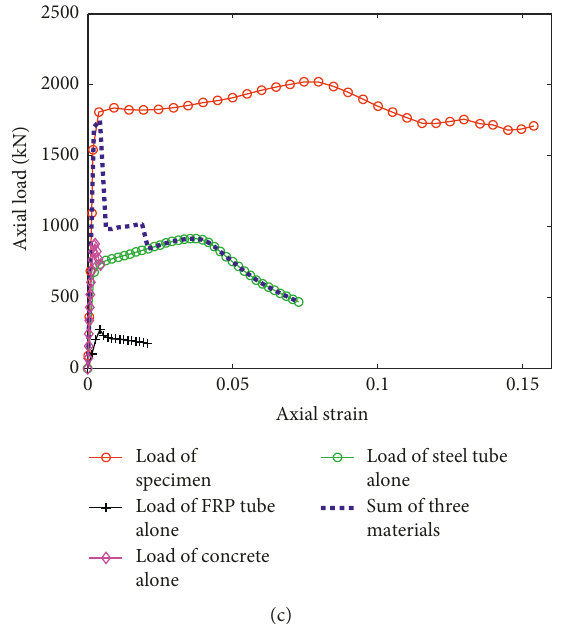
Figure 16: Composite effect of hybrid DTCCs. (a) A4-F80-M1 ( θ � ± 80 ° ; t � 4mm; Type A steel tube). (c) A4-F45-M1 ( θ � ± 45 ° ; t t frp